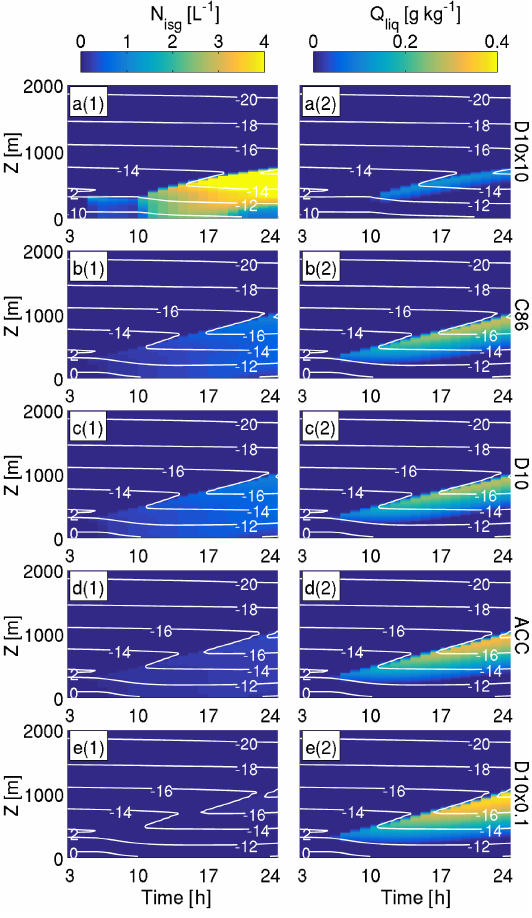
Figure 9. MIZ (case 2) simulations, presented similarly to Fig. 6.